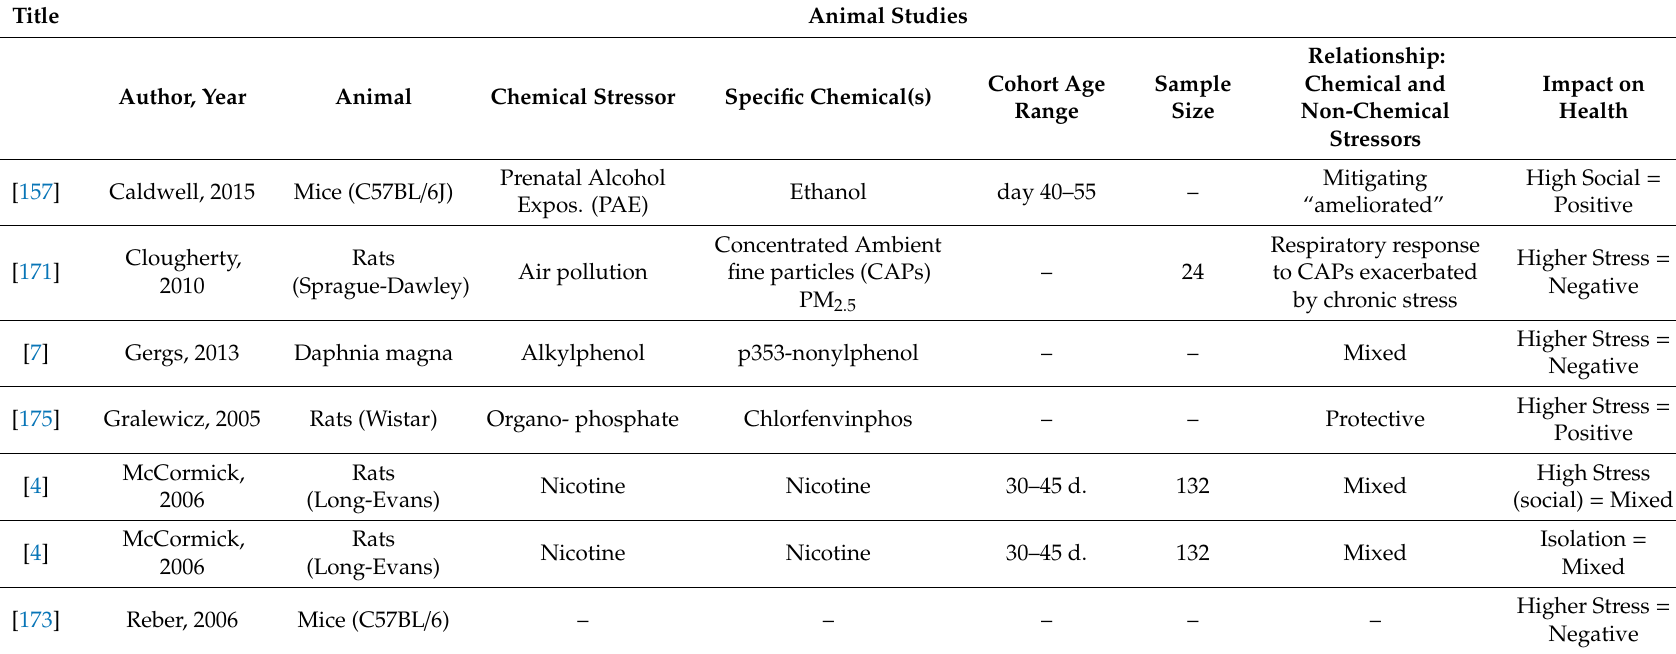
Table 3. Summary of the studies included in review that were animal